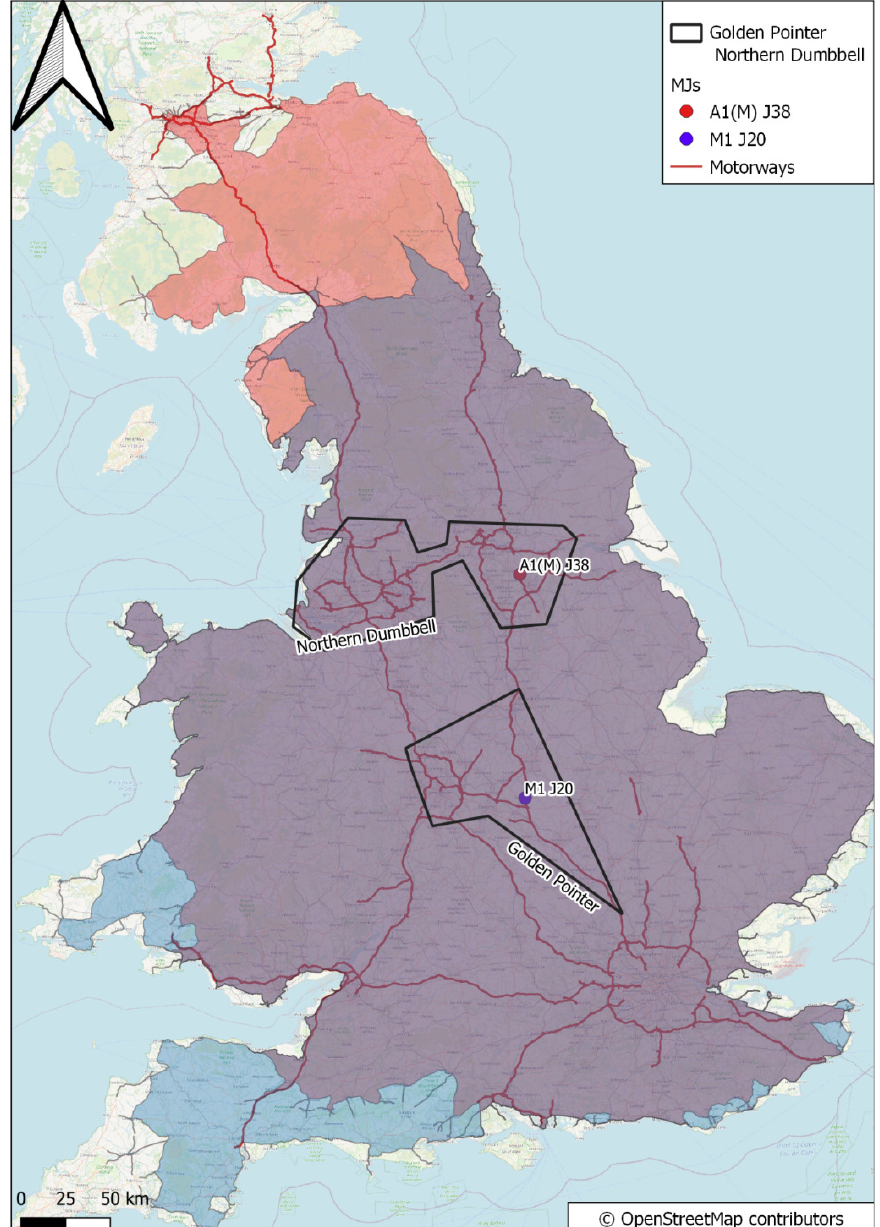
Figure 4. Four‐hour isochrones for junction 38 of the A1 and junction 20 of the